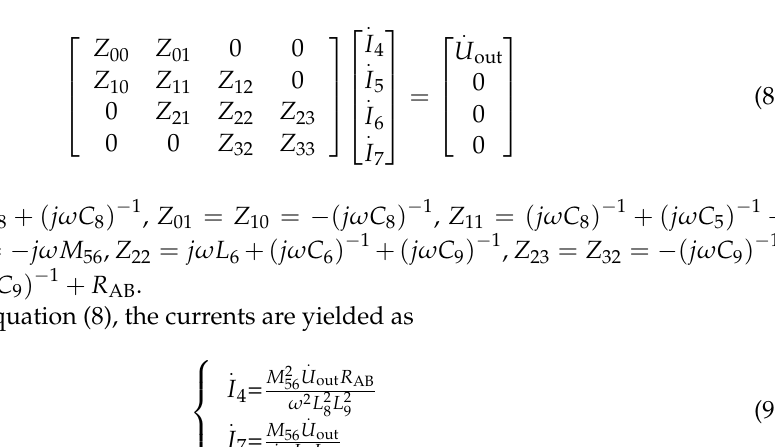
Figure 5. LCC-LCC topology circuit. According to Kirchhoff’s voltage law, we find